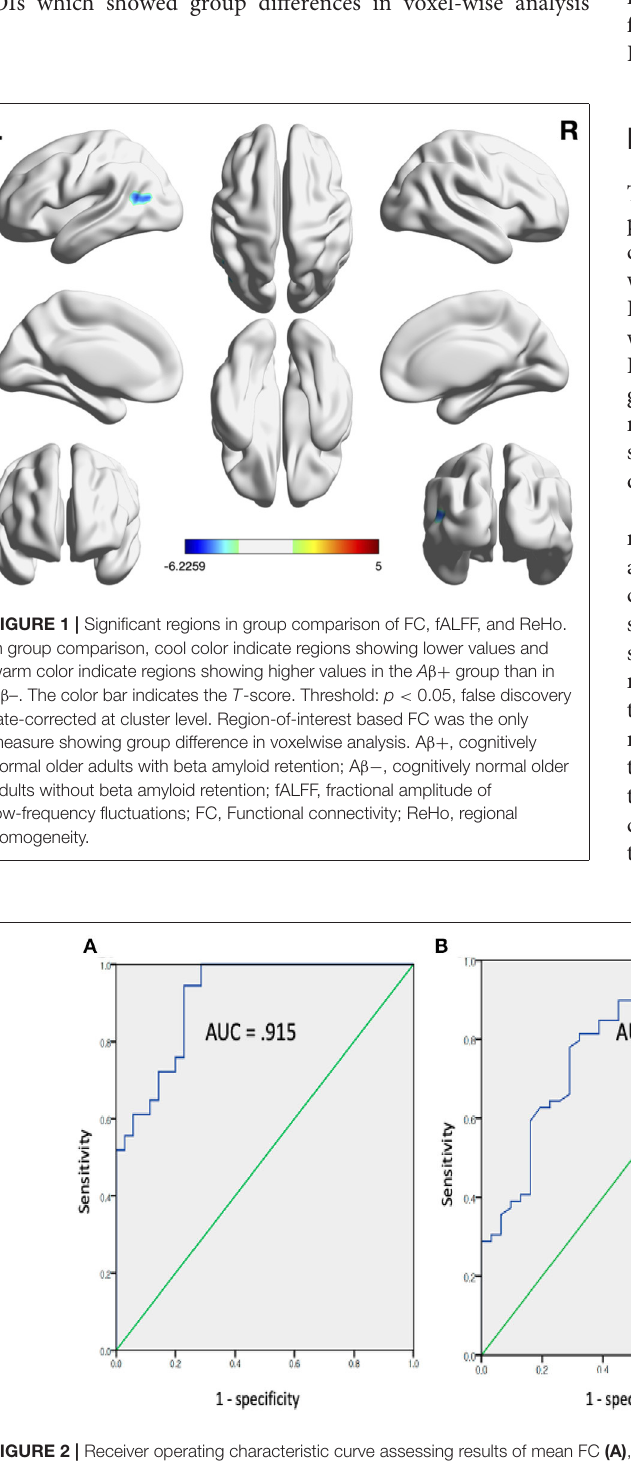
FIGURE 2 | Receiver operating characteristic curve assessing results of mean FC (A) , fALFF (B) , and REHO (C) values in discriminating the A β + from the A β - groups ( A β + : cognitively normal order adults with beta amyloid retention, A β − : cognitively normal order adults with beta amyloid retention (fALFF, fractional amplitude of low-frequency fluctuations; ReHO, regional